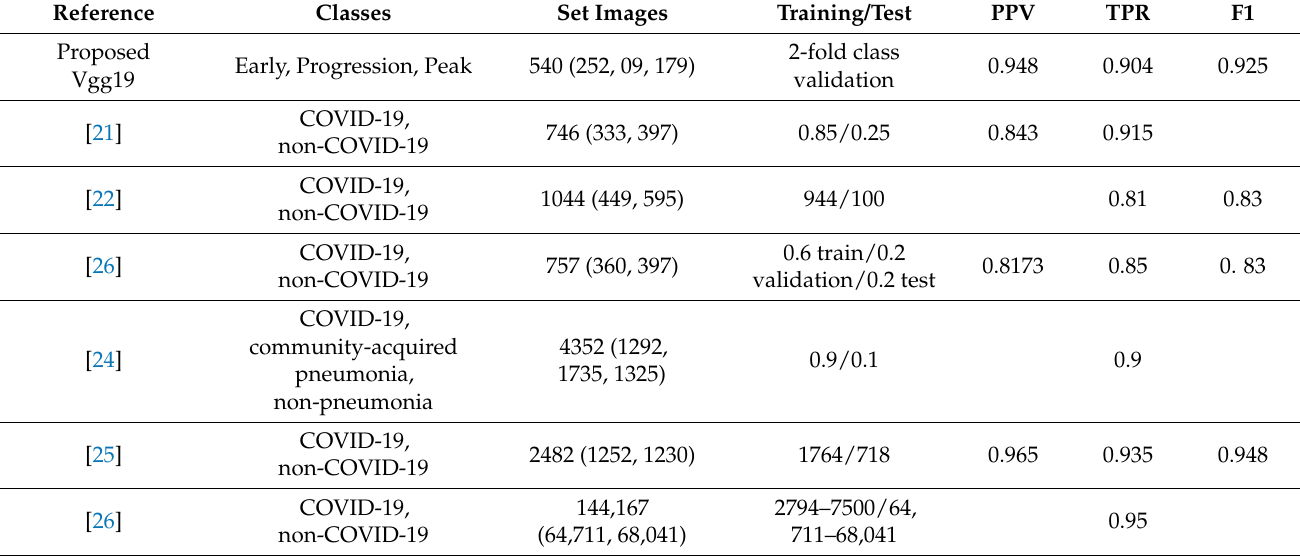
Table 3. Comparison of COVID-19 diagnosis classification methods